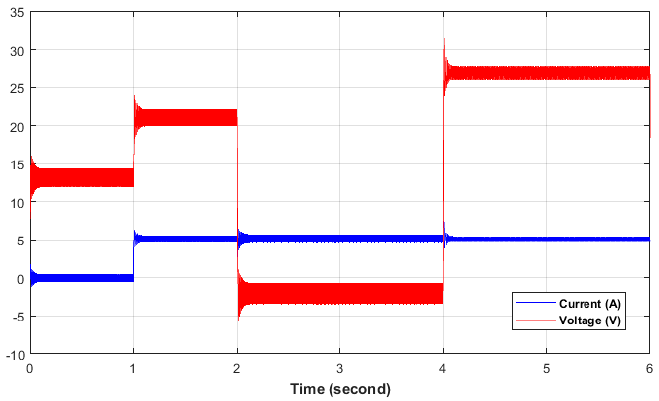
Figure 6. Armature voltage and current of BLDC motor in the simulation.